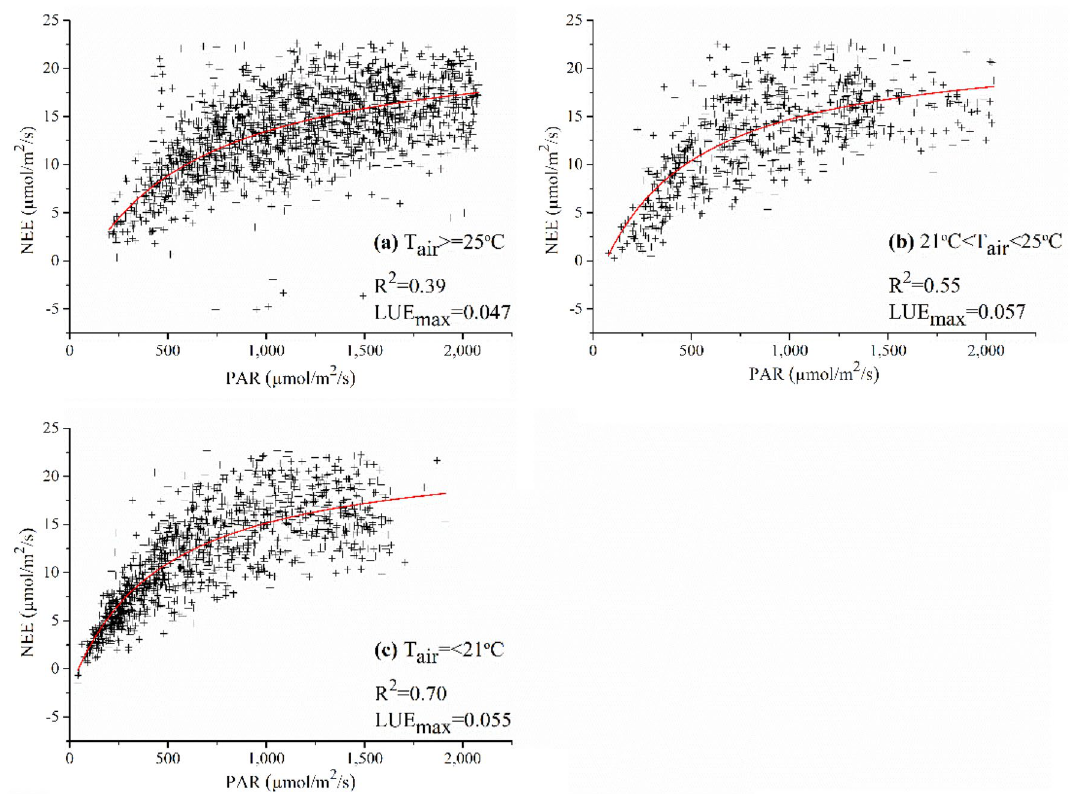
Figure 1. The responses of NEE to PAR at: ( a ) T air ≥ 25 °C, ( b ) 21 °C < T air < 25 °C, and ( c ) T air < = 21